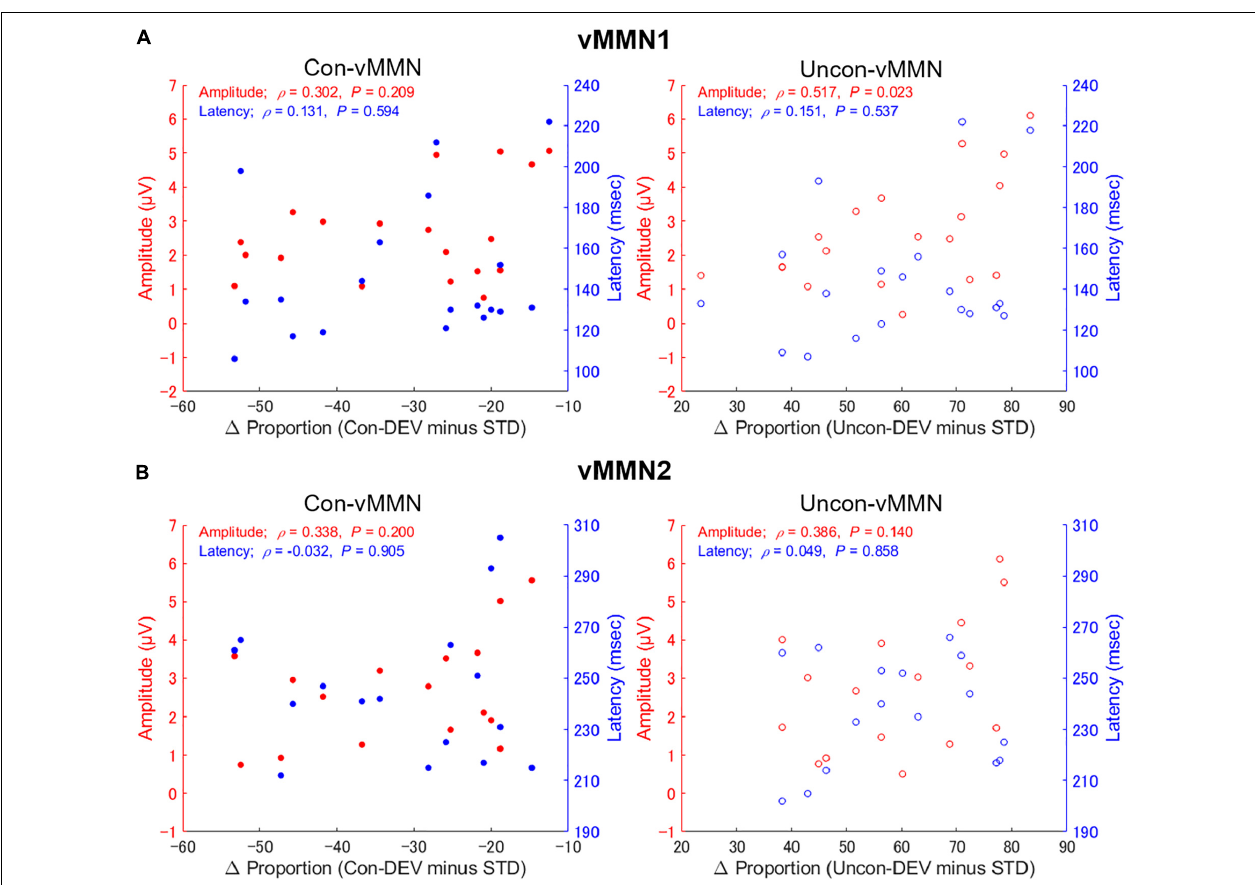
FIGURE 5 | Relationship between proportion of perceptual alternation and vMMNs across participants. The correlations between the differential proportion of perceptual alternation (Uncon-DEV condition – STD condition; Con-DEV condition – STD condition) and vMMN (Uncon-vMMN; Con-vMMN) are shown for vMMN1 (A) and vMMN2 (B) . There was a significant correlation between differential proportion (Uncon-DEV condition – STD condition) and an enhancement of the Uncon-vMMN, indicating that the Uncon-vMMN is relevant to making an unconsciously presented image consciously